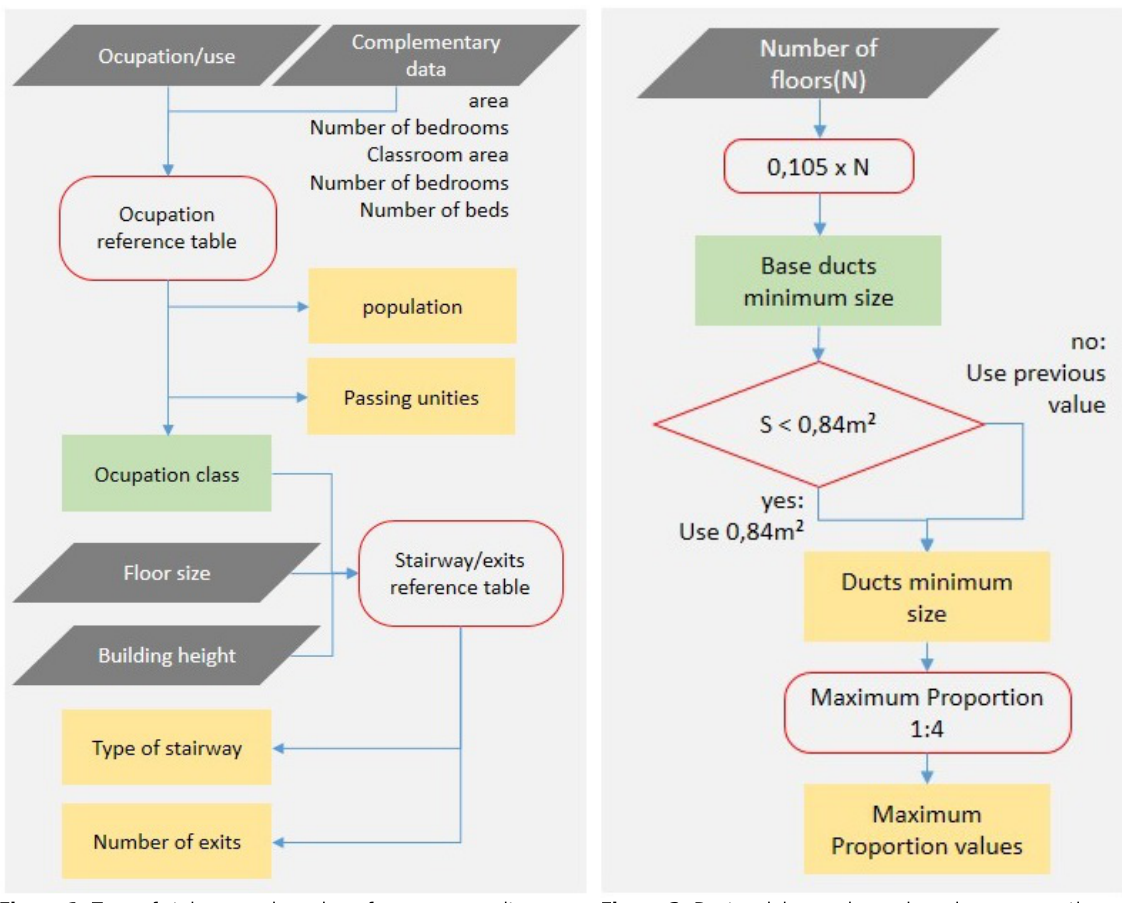
Figure 1. Type of stairway and number of emergency exits flowchart.